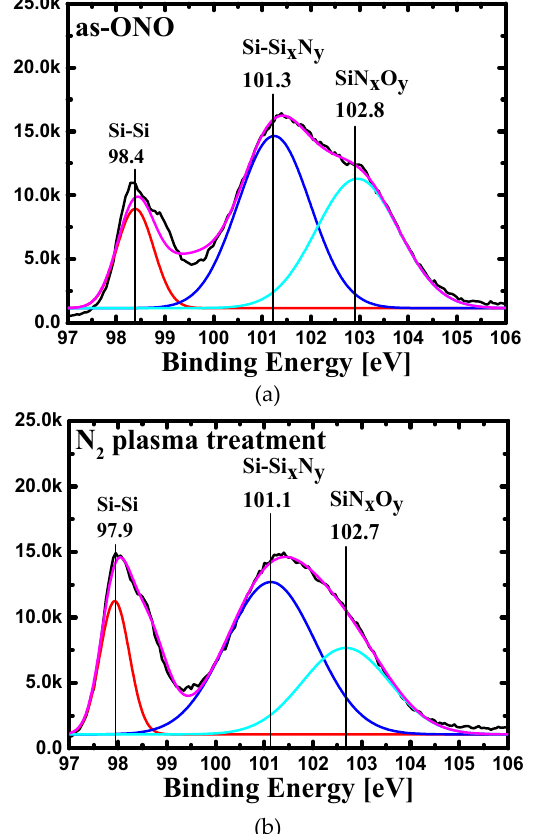
Figure 7. X-ray Photoelectron Spectroscopy (XPS) results of Si2p multi peak fitting of nitride/oxide interface ( a ) as-nitride (without N 2 plasma treatment) and ( b ) N 2 plasma treated nitride.